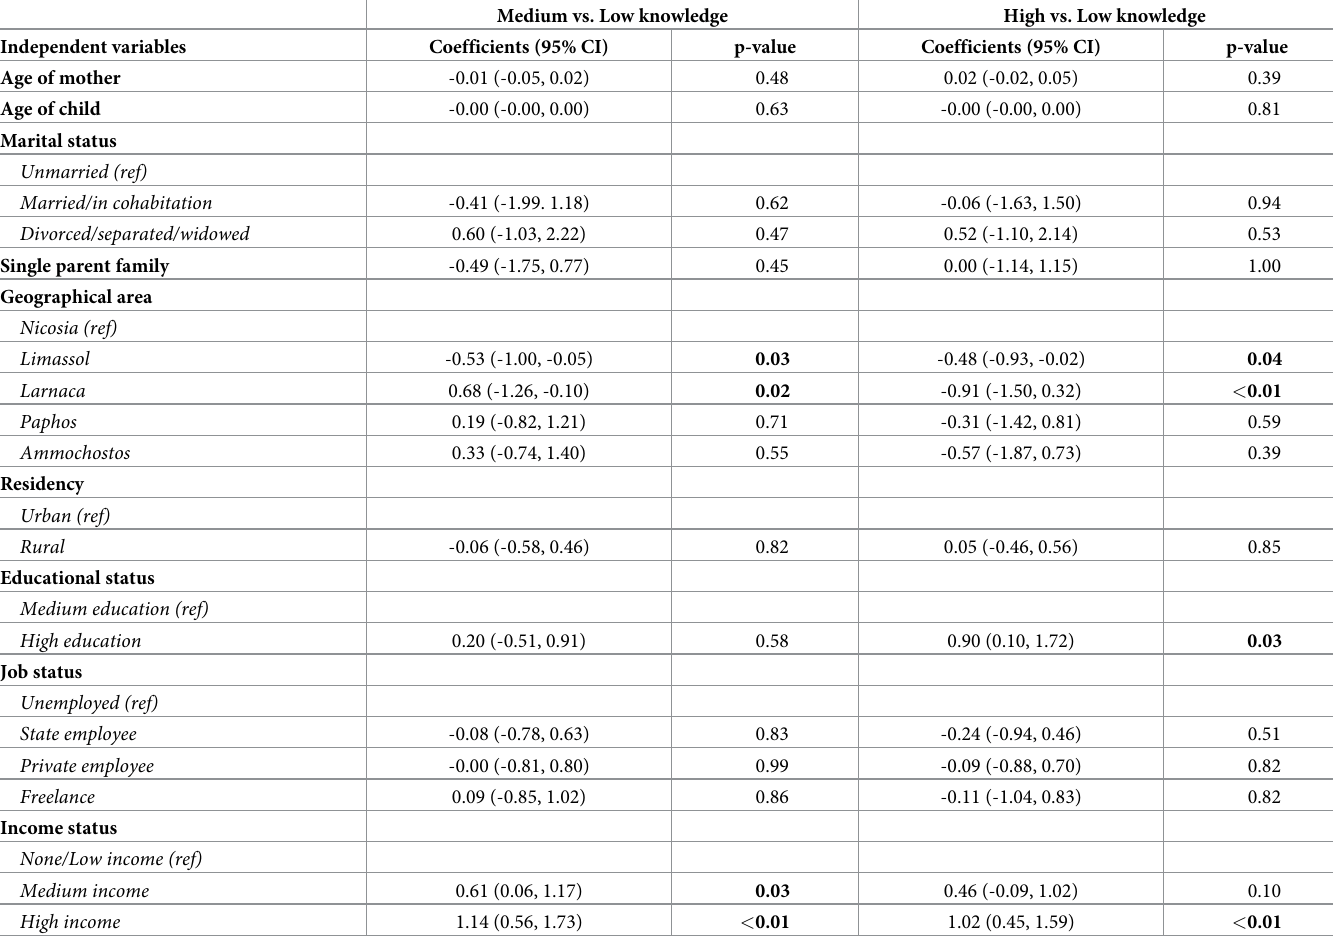
Table 3. Multiple logistic regression of vaccination knowledge (base outcome: Low knowledge) after accounting for demographics and socio-economic